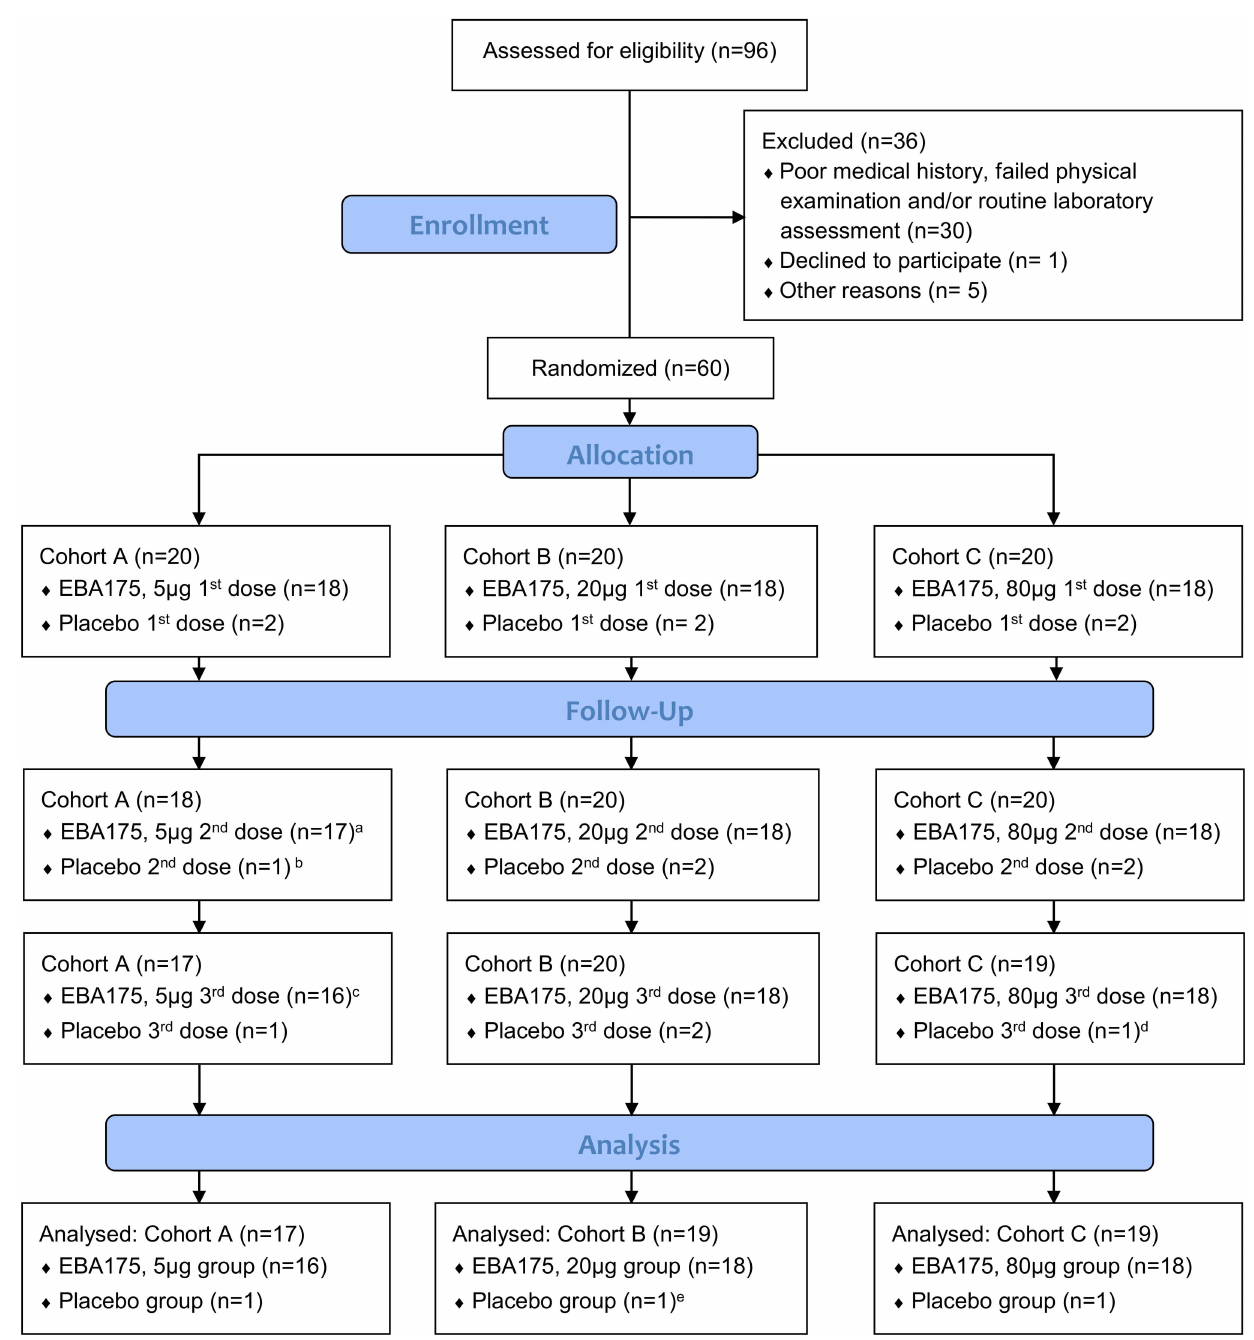
Fig 1. Trial profile. a Vaccination was discontinuedin one subjectdue to blood phobia. b One subject was excluded fromfurthervaccinations due to severe anemia. c One subjectmigratedout of the countrywithoutpriornotification. d One subjectvoluntarilywithdrew to relocateto anothertown. e One subjectdiscontinuedthe study and was lost to follow up for safety evaluation afterreceiving all threevaccinations. All attemptsto find this subject failed. Abbreviation: EBA-175RII-NG–Erythrocytebindingantigen175 regionII